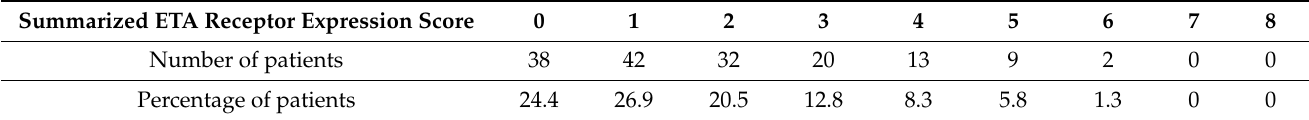
Table 3. The summarized ETA receptor expression score ( n = 156).